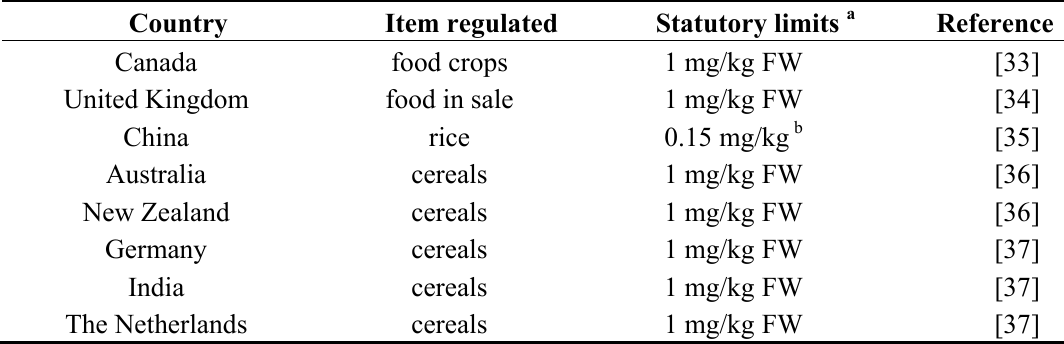
Table 3. Regulation limits of As concentration in cereals or food crops established by different